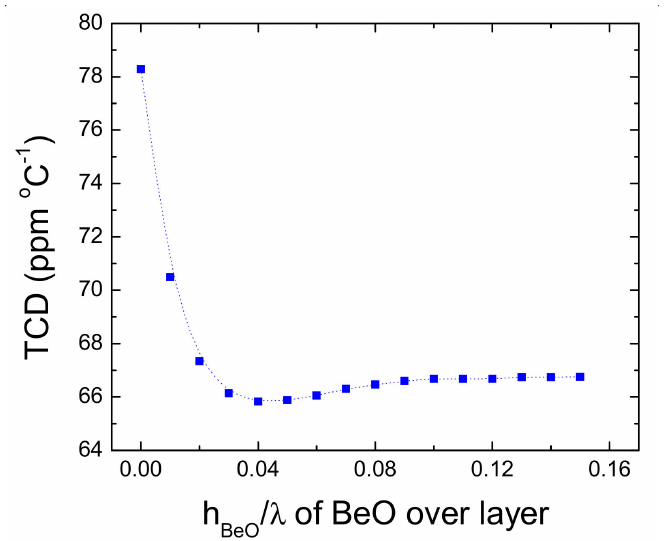
Figure 3. Variation of temperature coefficient of delay (TCD) with normalized thickness of BeO over layer in BeO/128 ◦ YX LiNBO 3 SAW layered